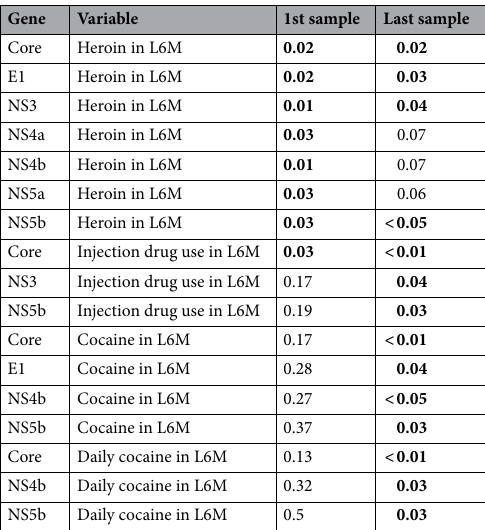
Table 3. Significant changes in viral diversity due to behavioural variables. Diversities were compared for each individual’s first and final time points for each group using a Mann–Whitney–Wilcoxon test. L6M—last 6 months. Significance was determined with p values less than 0.05 (in